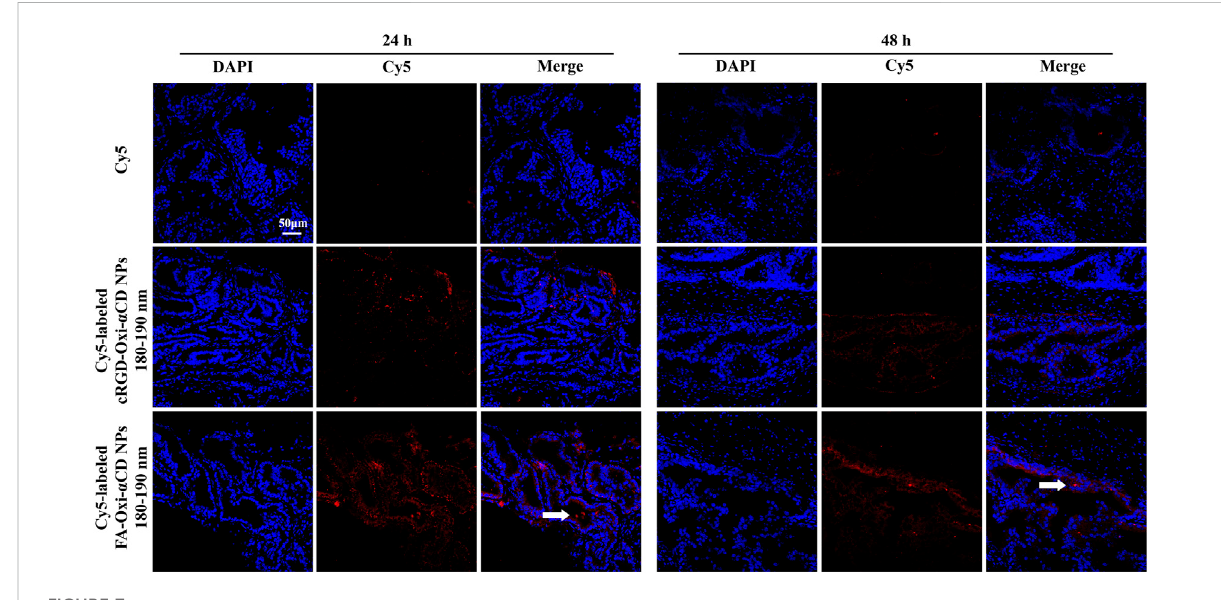
FIGURE 7 CLSM images of prostate tissues treated with Cy5, Cy5-labeled RGD-Oxi- α CD NPs (180 – 190 nm) and Cy5-labeled FA-Oxi- α CD NPs (180 – 190 nm) for 24 and 48 h. Red indicates NPs, and blue indicates DAPI. The scale bar represents 50 μ m.